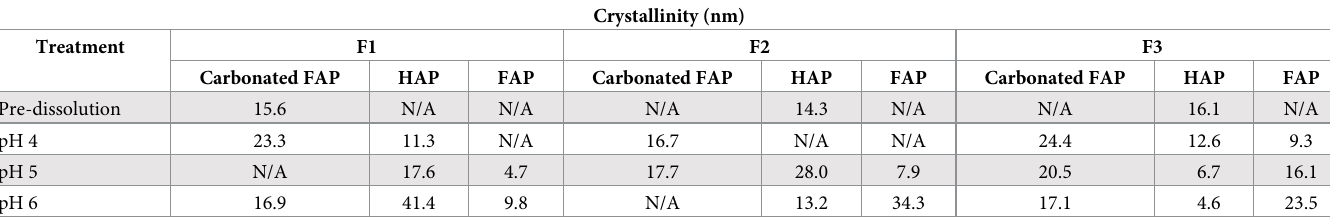
Table 6. Crystallite size and structural order of detected apatite phases calculated using the Sherrer equation.